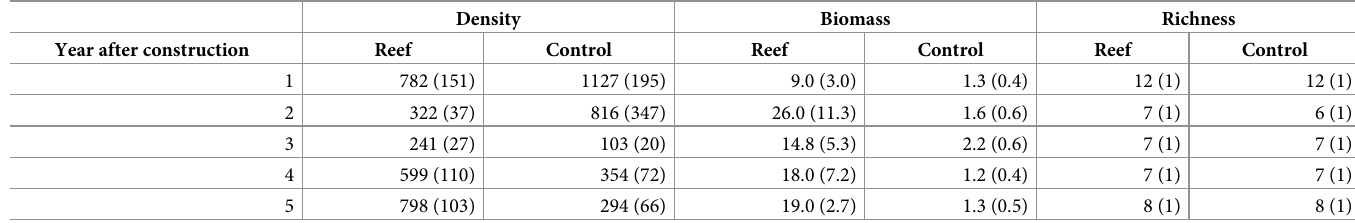
Table 2. Annual mean (SE) resident motile fauna density (ind. m -2 ), biomass (g m -2 ) and richness (species tray -1 ) at constructed reef and control sites in years 1, 2, 3, 4, and 5 after reef construction. Density Biomass